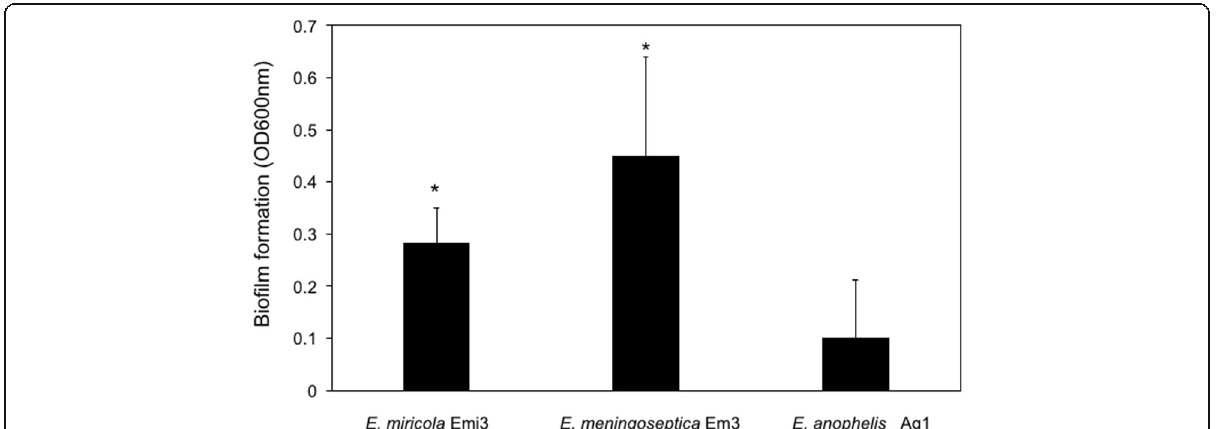
Fig. 3 In vitro biofilm assay in the selected Elizabethkingia sp. The cells were first cultured by shaking in TSB at 37 °C overnight. The cell density was adjusted to the same OD at 600 nm (0.1). 200 μ l of cells were placed on 96-well plates for 24 h. The biofilm assay was carried out using crystal blue staining [49]. Values are mean values for single measurements from eight independent cultures. The error bars are standard deviations. The statistical test was the Student ’ s t-test. The asterisk indicates a significant difference compared to biofilm formation in E. anophelis Ag1 ( p <